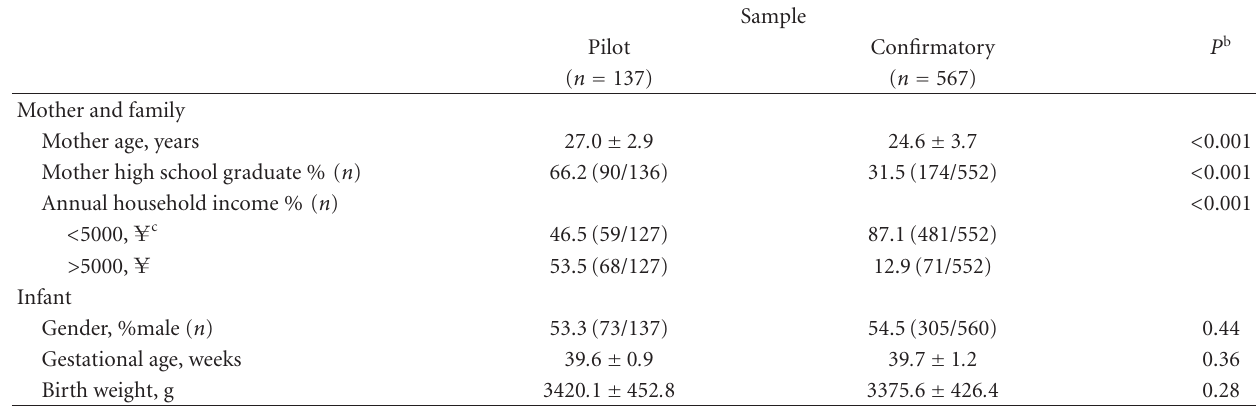
Table 2: Background characteristics of the two samples in China a .